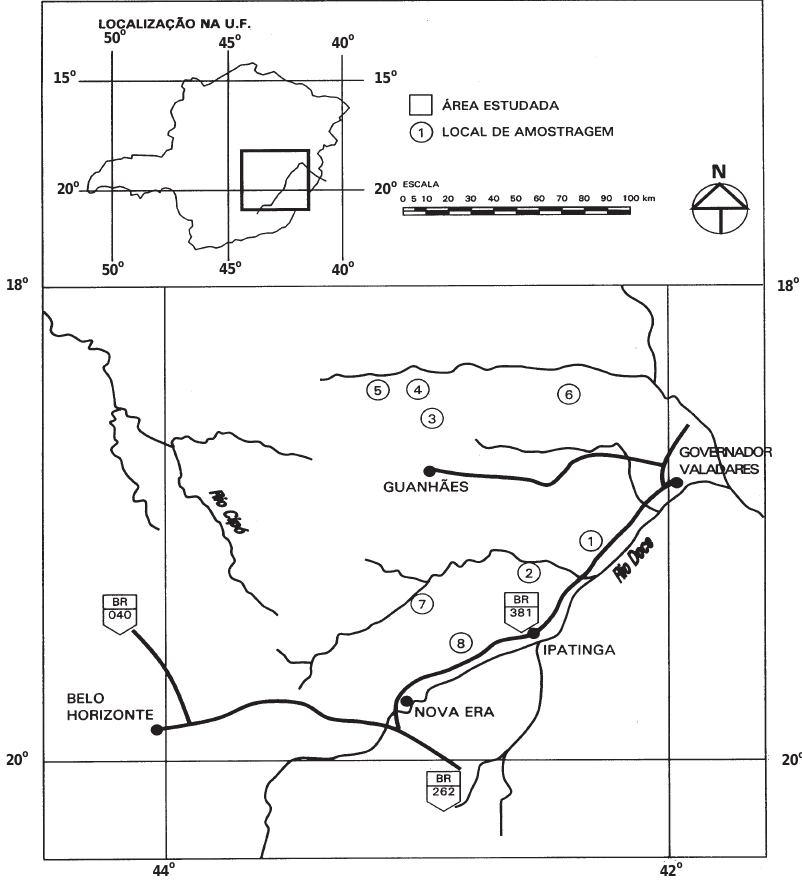
Figura 1. Mapa de situação na Unidade Federativa (U.F.) e localização dos solos